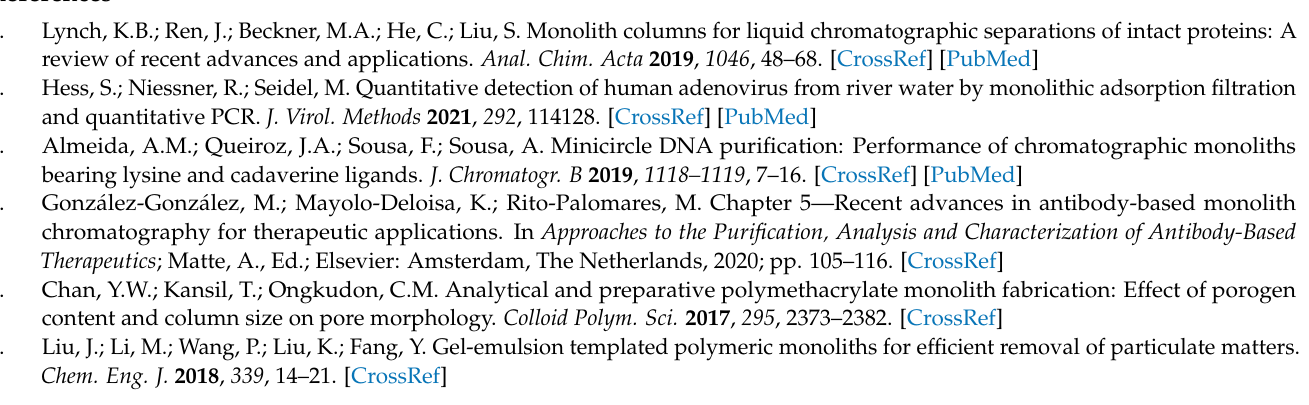
(a) Original SEM image, (b) threshold of the image set, and (c) the particle outline created with Image J software for the particle size measurement. Figure S2: Images of monolith middle part at 50:50 template/monomer ratio. (a) Original SEM image, (b) threshold of the image set, and (c) the particle outline created with Image J software for the particle size measurement. Figure S3: Images of monolith inner part at 50:50 template/monomer ratio. (a) Original SEM image, (b) threshold of the image set, and (c) the particle outline created with Image J software for the particle size measurement. Figure S4: Images of monolith outer part at 60:40 template/monomer ratio. (a) Original SEM image, (b) threshold of the image set, and (c) the particle outline created with Image J software for the particle size measurement. Figure S5: Images of monolith middle part at 60:40 template/monomer ratio. (a) Original SEM image, (b) threshold of the image set, and (c) the particle outline created with Image J software for the particle size measurement. Figure S6: Images of monolith inner part at 60:40 template/monomer ratio. (a) Original SEM image, (b) threshold of the image set, and (c) the particle outline created with Image J software for the particle size measurement. Figure S7: Images of monolith outer part at 70:30 template/monomer ratio. (a) Original SEM image, (b) threshold of the image set, and (c) the particle outline created with Image J software for the particle size measurement. Figure S8: Images of monolith middle part at 70:30 template/monomer ratio. (a) Original SEM image, (b) threshold of the image set, and (c) the particle outline created with Image J software for the particle size measurement. Figure S9: Images of monolith inner part at 70:30 template/monomer ratio. (a) Original SEM image, (b) threshold of the image set, and (c) the particle outline created with Image J software for the particle size